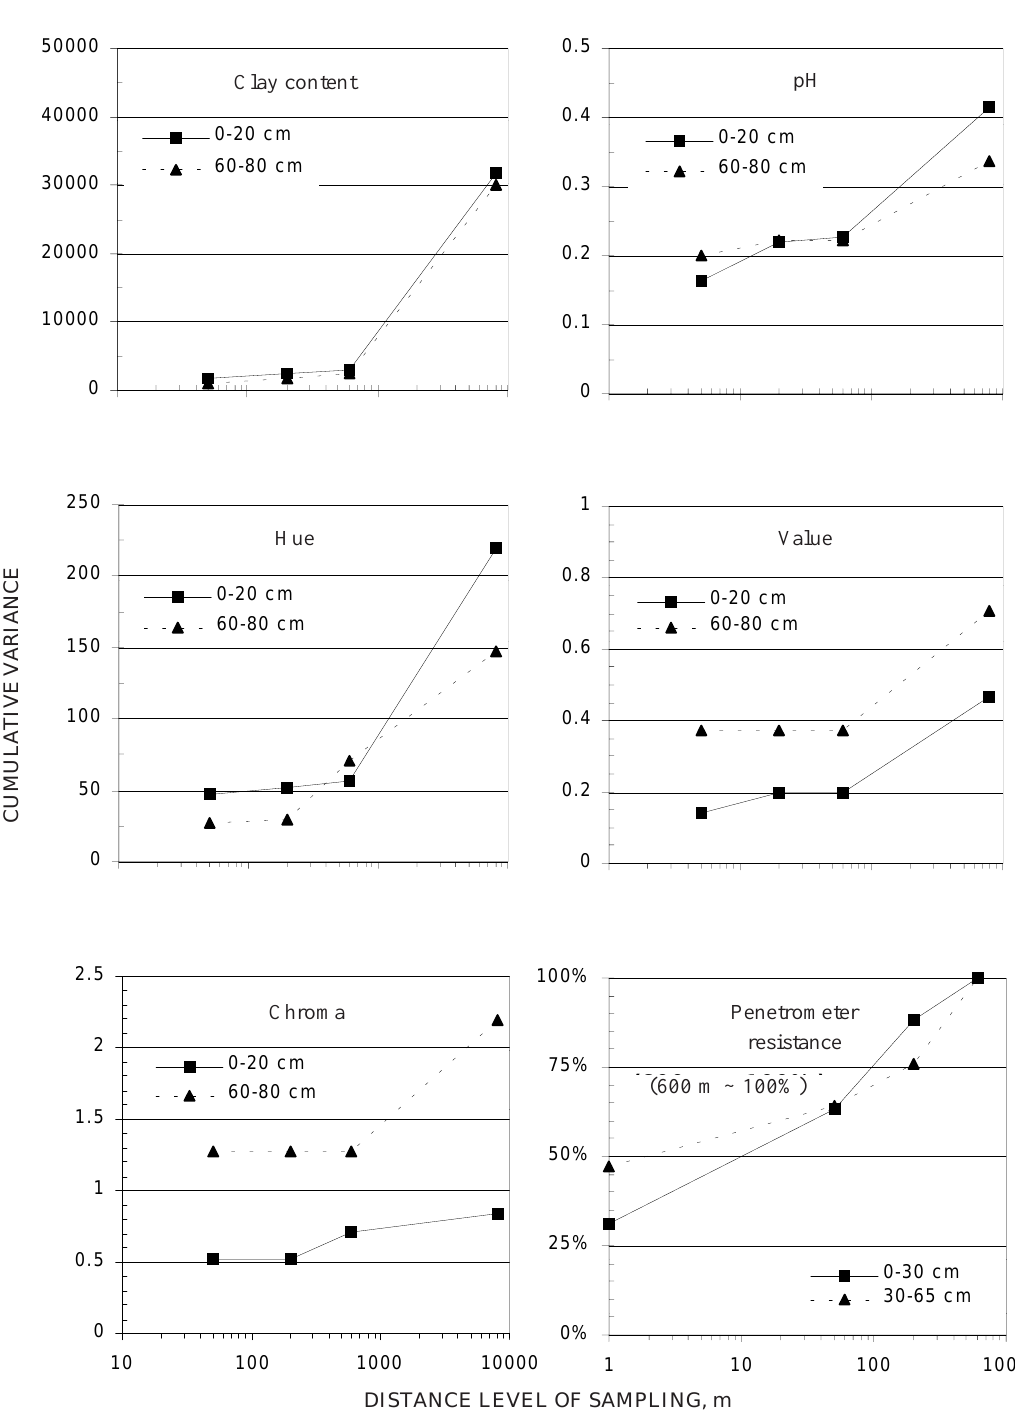
Figure 3. Nested variograms for the Araras region.